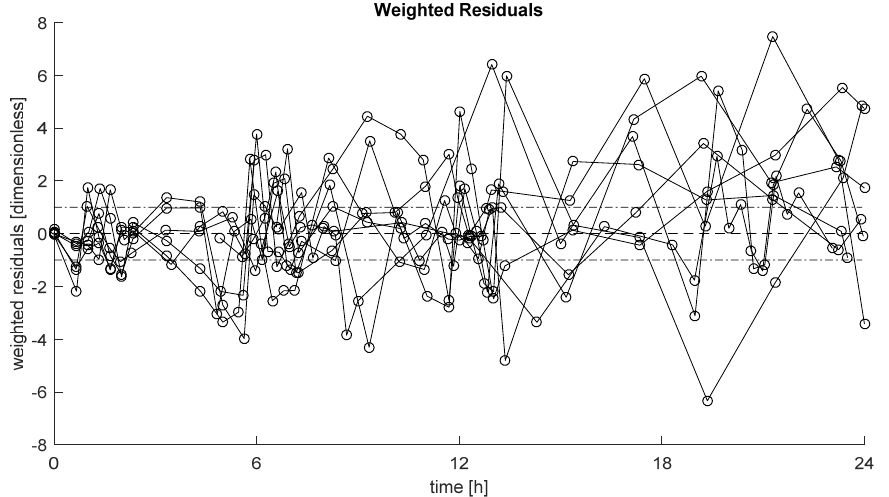
Figure 3. Weighted residuals of the selected model in each subject. Dashed line represents zero value, while dashed-dotted lines represent [ − 1, +1] interval.